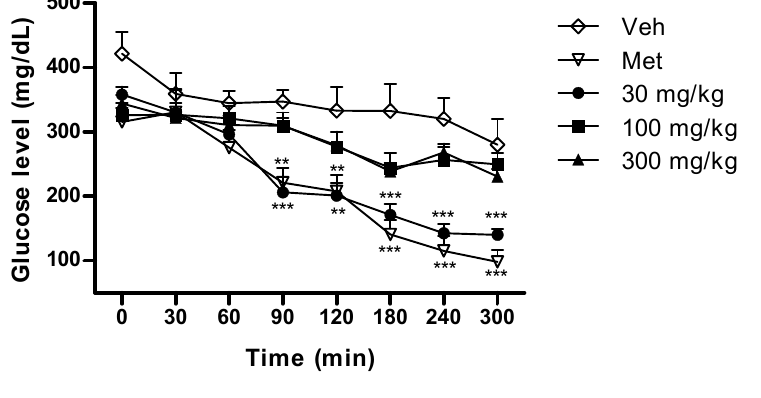
Figure 3. Antihyperglycaemic effect of KPME on STZ induced diabetic rats. Data represents the mean ± SEM, n > 6, Veh (vehicle), Met (metformin, 100 mg/Kg). ** p < 0.01, *** p <